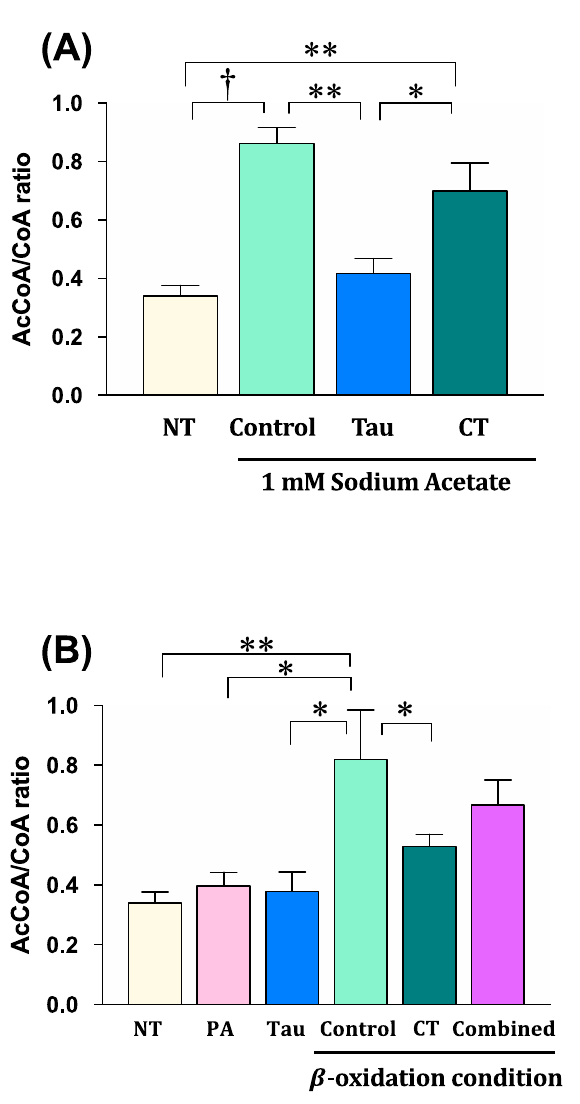
Figure 5. Mitochondrial acetyl-CoA/free-CoA ratio in the myotube exposed to acetate ( A ) and fatty acid ( B ) with taurine or/and carnitine treatments. ( A ) The myotube was exposed to 1 mM sodium acetate with 2 mM taurine or 300 µM carnitine for 24 h. Abbreviations: NT; no treatments with acetate, taurine, or carnitine, Control; 1 mM sodium acetate alone, Tau; 2 mM taurine with 1 mM sodium acetate, CT; 300 µM carnitine with 1 mM sodium acetate. ( B ) The myotube was exposed to